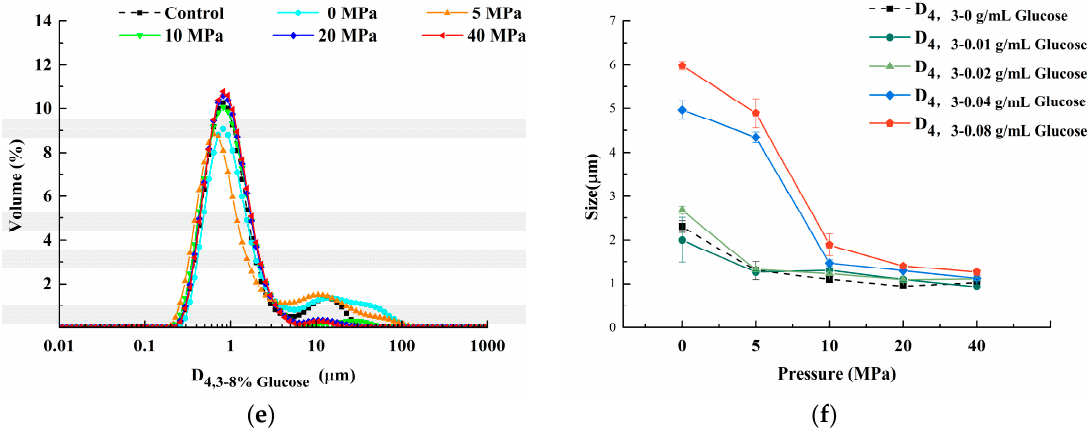
Figure 4. The particle size of LWE under different homogenization pressure treatment and glucose concentrations. Note: ( a – e ) presented the particle size distribution of the LWE after adding 0 g/mL, 0.01 g/mL, 0.02 g/mL, 0.04 g/mL, and 0.08 g/mL glucose in turn. ( f ) Presented the results of average volume particle size D[4,3] of LWE under different homogenization pressure treatment and glucose concentration.